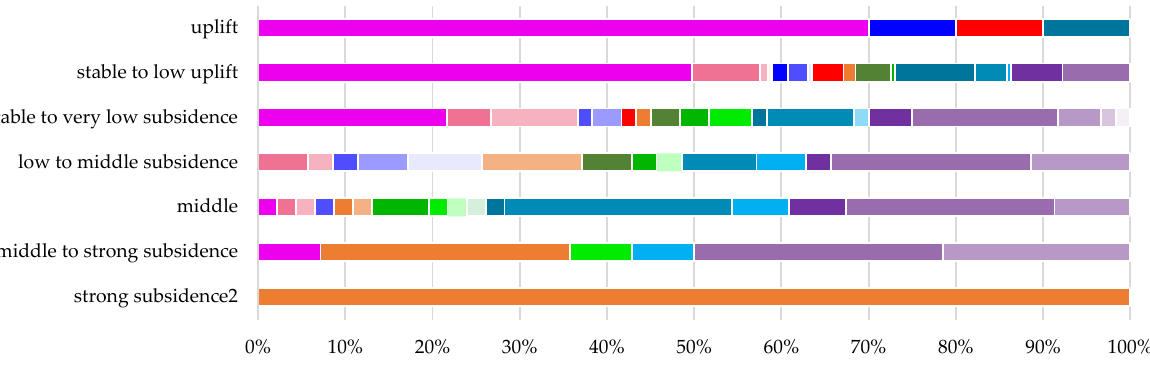
Figure 8. (LR vs. TC) vs. subsidence values. Labels correspond to the matrix (LR vs. TC). Input data and output graphic detail in Figure S1 and Table S1. Note that medium values of subsidence correspond to high LR and high TC (mostly E and F), whereas the highest vertical displacements correspond to high LR and low TC.